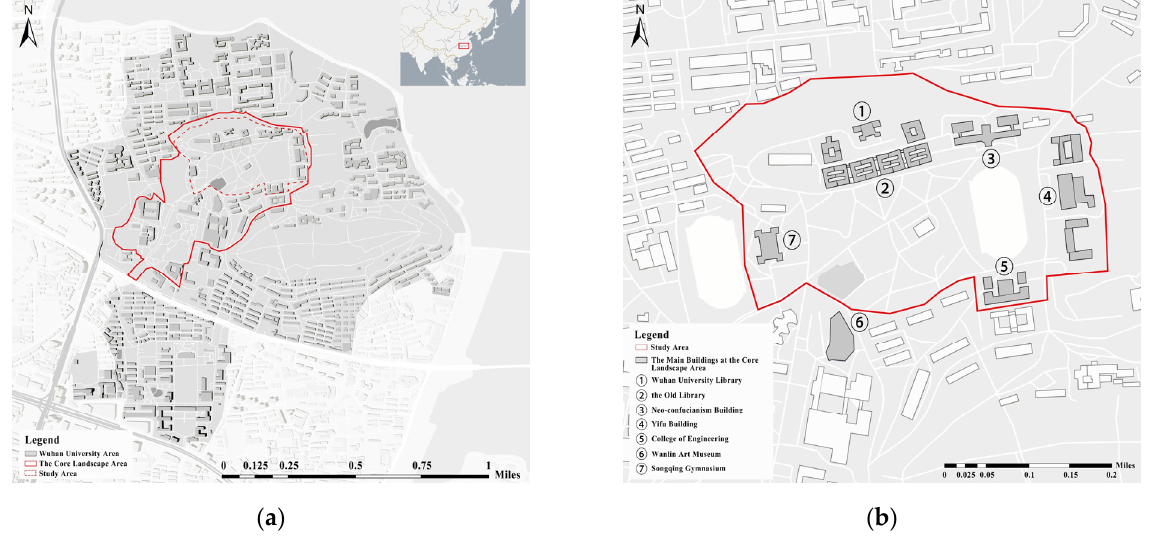
Figure 1. Location of the case study area. ( a ) The study area is located in Hubei province, China. The gray area represents the Wuhan University area, while the area within the red line represents the core cultural landscape area; ( b ) it shows 7 main buildings in the core landscape area.